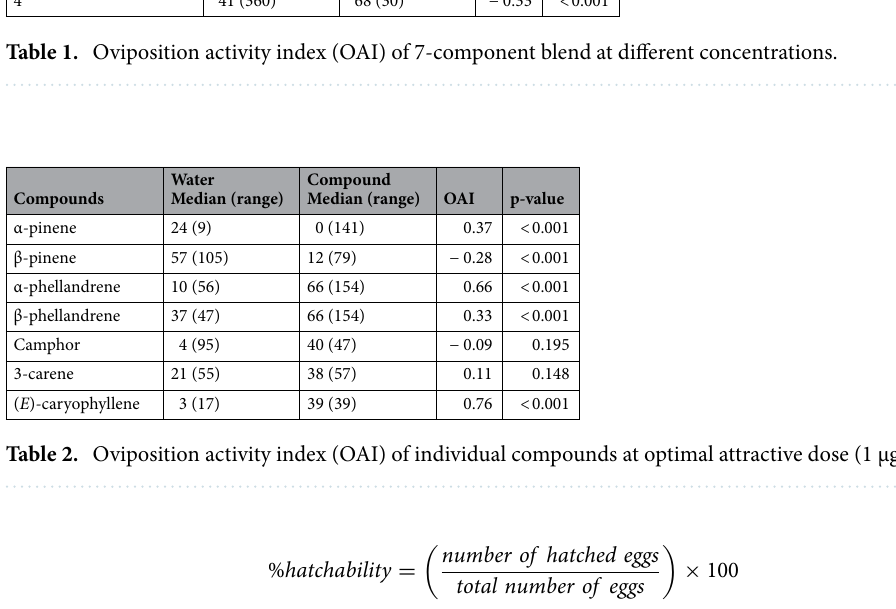
Table 2. Oviposition activity index (OAI) of individual compounds at optimal attractive dose (1 µg/µL).